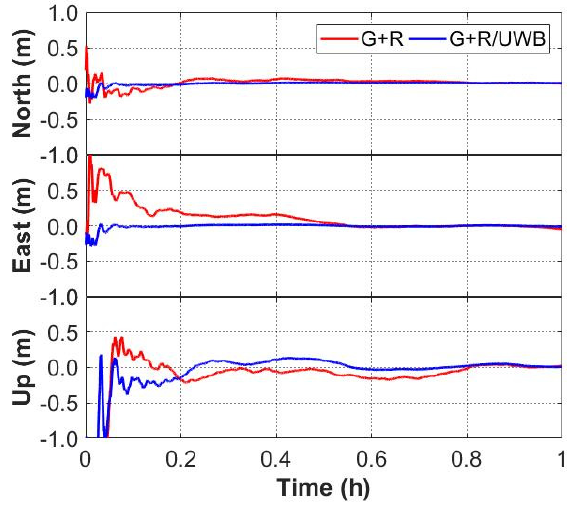
Figure 7. Positioning errors of GPS + GLONASS and GPS + GLONASS/UWB solutions.